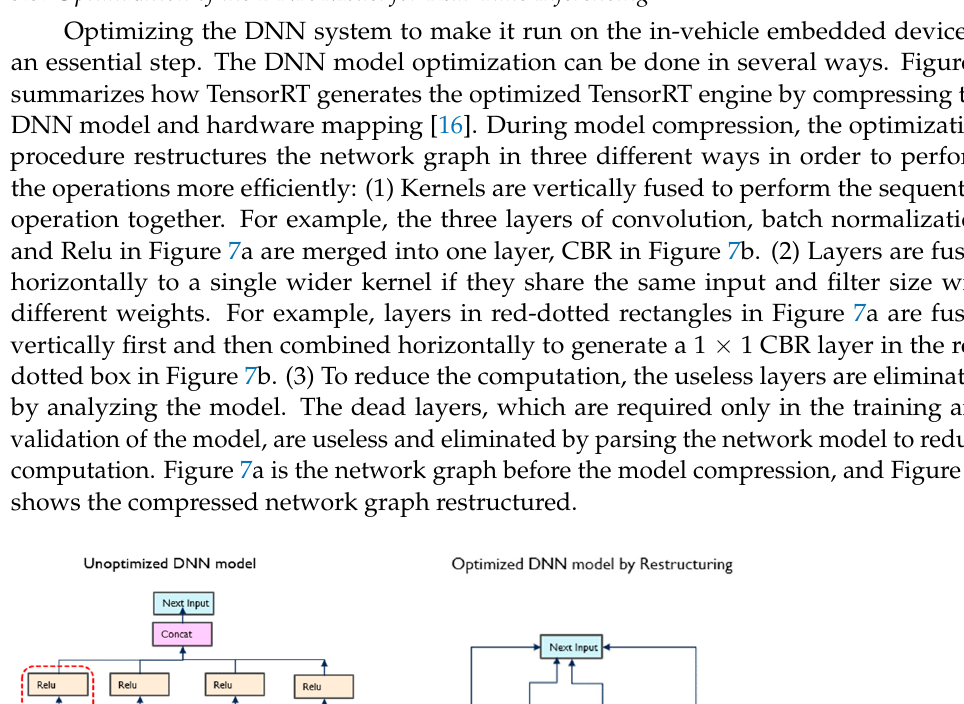
Figure 8. Optimization and deploy procedures. 4. Experiments on the Real-Time Inferencing System for Obstacle Detection Five di ff erent DNN models were developed by freezing di ff erent layers using the transfer learning technology. Those fi ve di ff erent DNN models are de fi ned below: • TL Model #1: the DNN model is re-trained from scratch by freezing the Darknet53 body (185 layers) and retraining the whole 67 layers after the Darknet; •